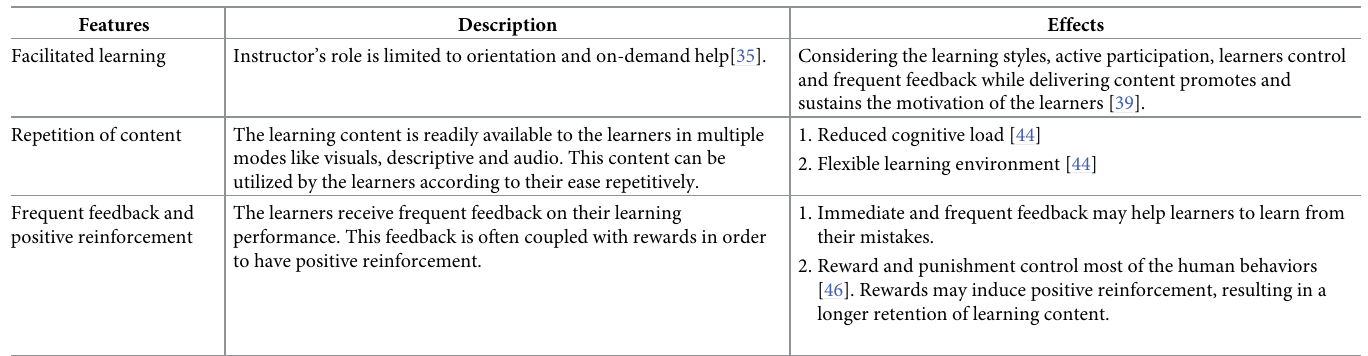
Table 2. Features for content delivery to